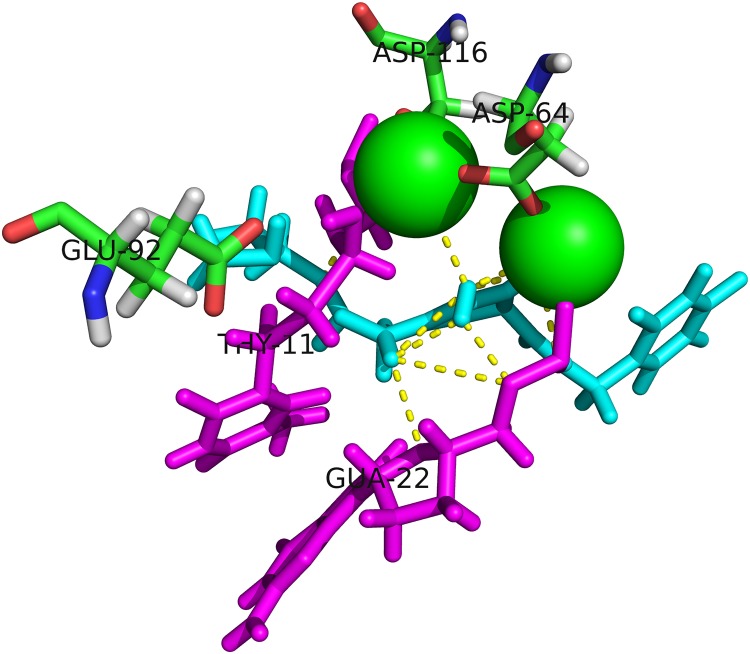
HIV-1C Integrase active site showing interactions with DNA, MG and drug Dolutegravir.Magnesium2+ ions (green spheres) are shown sitting in close proximity with Dolutegravir (cyan) within the binding pocket (DDE motif) residues are labelled and shown as sticks. Two DNA residues: THY11 and GUA22 (magenta sticks) are shown expressing polar interactions with Dolutegravir and the drug also interacts with both MG ions as shown. Dashed yellow lines show polar contacts.